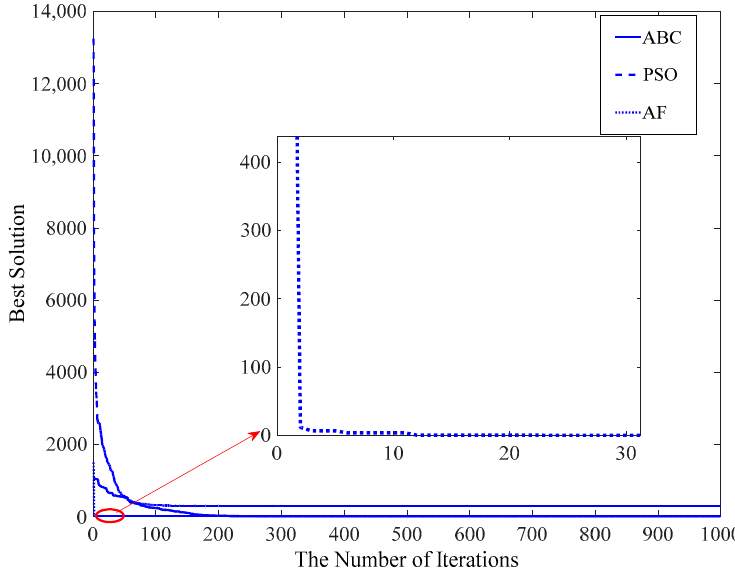
Figure 13. The convergence curve of the three algorithms for Griewank function in 50-dimensional space.